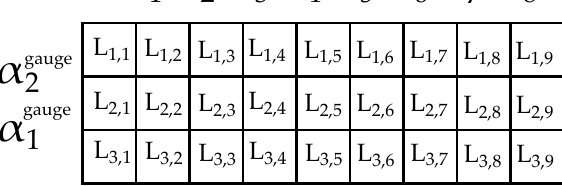
Figure 3. Representation graph for ( 3 ; 9 ) of SU(3) gauge (cid:2) U(9) BG . L i;j = L SU(3) indicates the fundamental weights of the respective groups. (cid:11) i are the simple roots of the classical (cid:13)avor symmetry U(9), and (cid:11) gauge those of the gauge group i